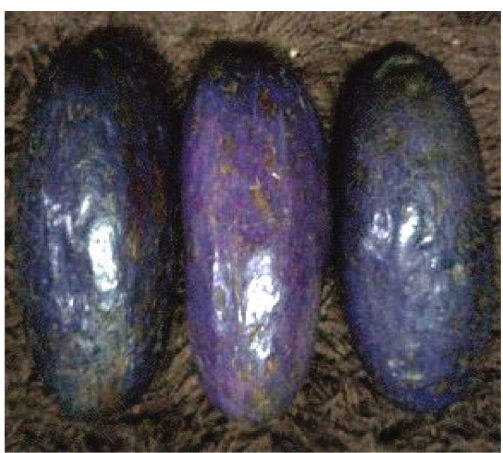
Figure 1: Mature sour fruits of safou ( D. edulis